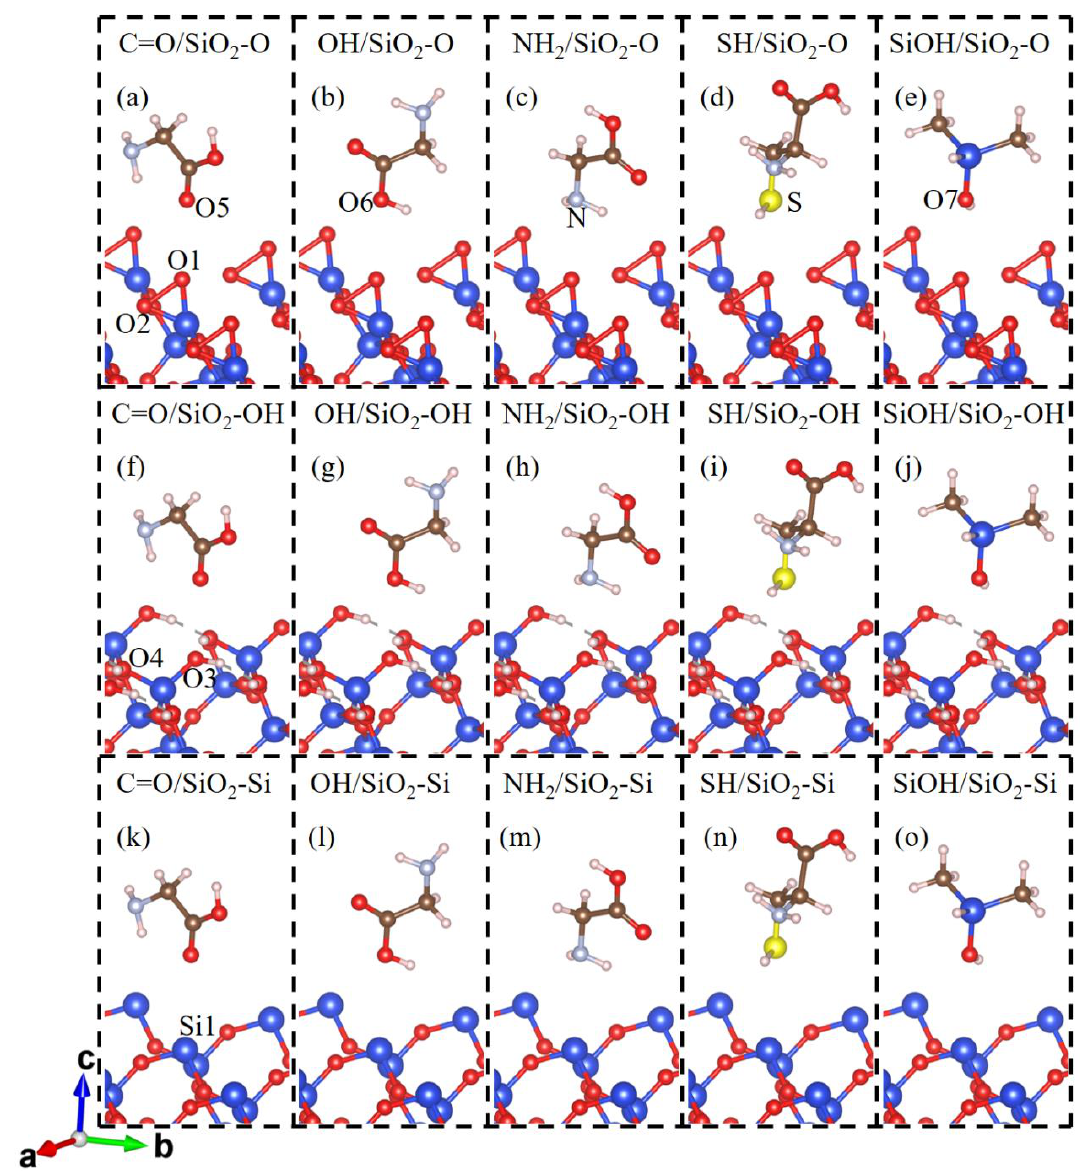
Figure 1. The initial contact conformation for ( a ) C=O group of glycine; ( b ) OH group of glycine; ( c ) NH 2 group of glycine; ( d ) SH group of cysteine; ( e ) SiOH group of dimethyl siloxane molecule on the O-terminated SiO 2 (001) (SiO 2 -O) surface; ( f ) C=O; ( g ) OH; ( h ) NH 2 ; ( i ) SH; ( j ) SiOH groups on the OH-terminated SiO 2 (001) (SiO 2 -OH) surface; ( k ) C=O; ( l ) OH; ( m ) NH 2 ; ( n ) SH; and ( o ) SiOH group on the Si-terminated SiO 2 (001) (SiO 2 -Si) surface. The Si, O, H, C, N, and S atoms are drawn in blue, red, white, brown, light blue, and yellow, respectively.